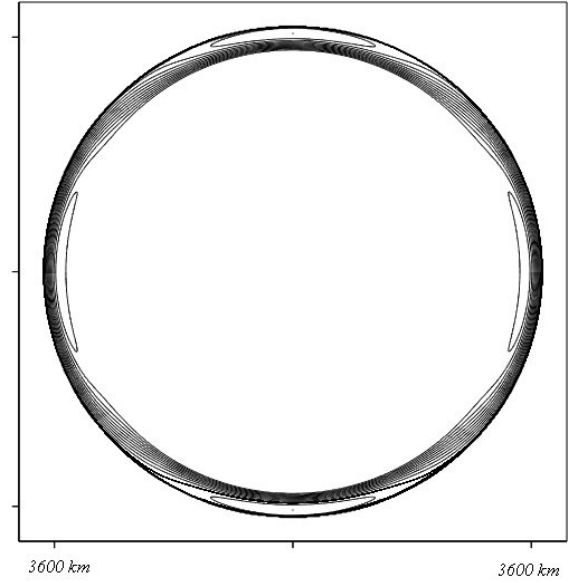
Fig. 3. The streamline pattern for the quadrupole case ( N = 2 );